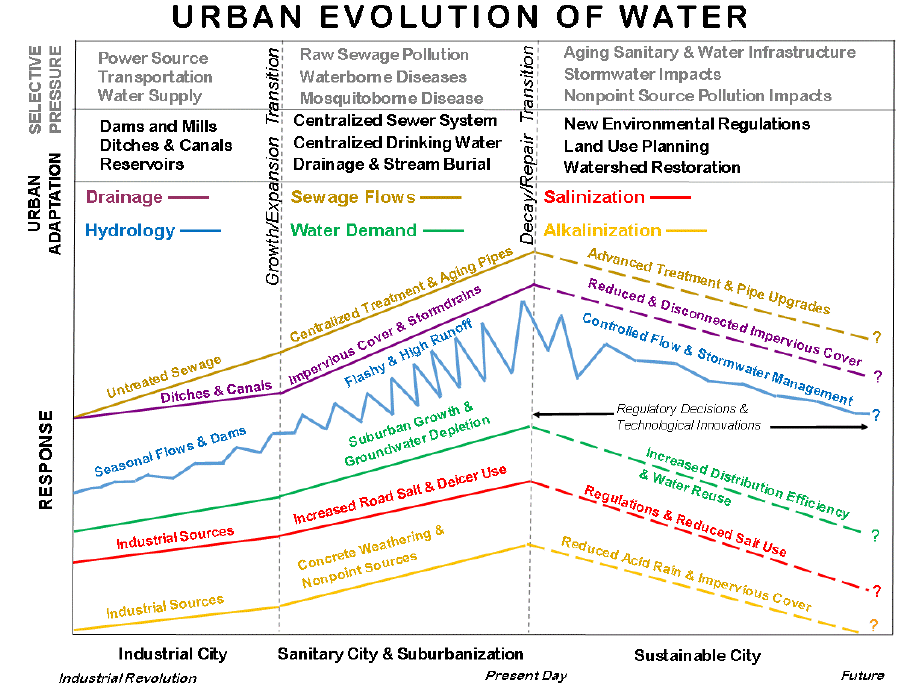
Figure 4. Urban evolution of water from the Industrial Revolution to the present. Hydrologic traits evolve across successive generations of urban ecosystems via shifts in selective pressures and adaptations over time. Urban evolution can occur across distinct stages and transitions where the adaptations of previous generations lead to urban selective pressures forcing the next generation of urban